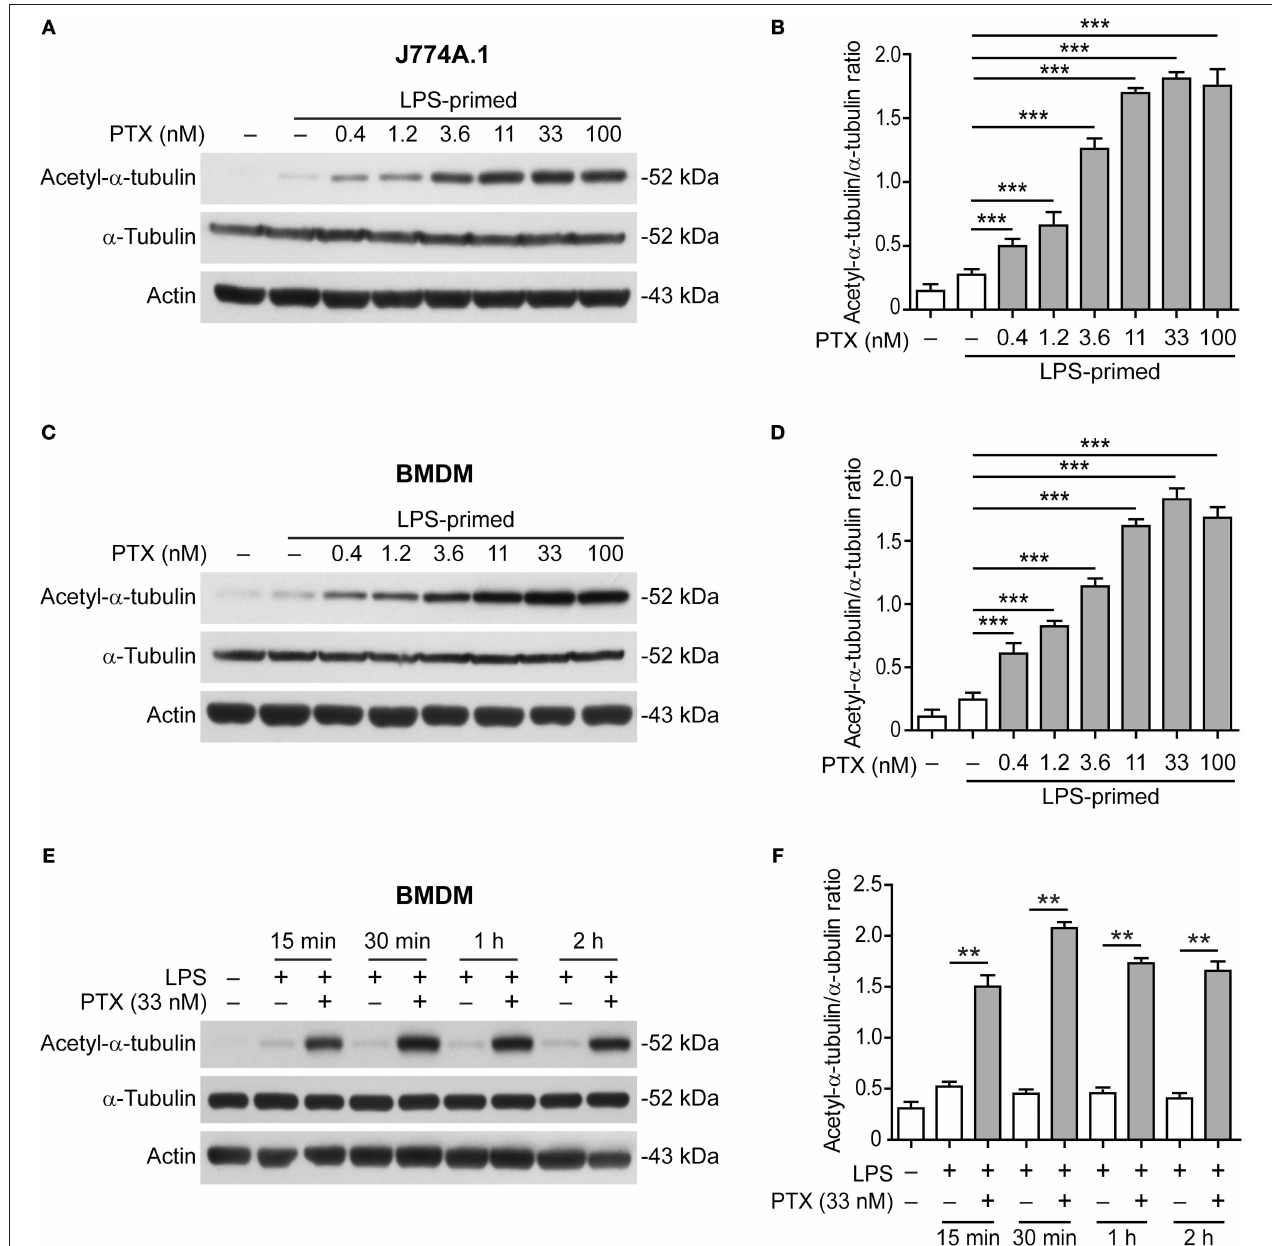
FIGURE 3 | Paclitaxel pretreatment increased the levels of acetylated α -tubulin. LPS-primed J774A.1 macrophages (A,B) and BMDMs (C–F) were pre-treated with graded concentrations of paclitaxel for 1h (A–D) or with paclitaxel (33nM) for indicated time periods (E,F) . Western blotting was used to assess the levels of indicated proteins in cell lysates (A,C,E) . Actin was used as the loading control. Histograms showing the quantification of acetylated α -tubulin relative to total α -tubulin are shown in (B,D,F) , respectively. Data were analyzed using the unpaired Student’s t -test (B,D) or non-parametric Mann–Whitney U -test (F) , which are shown as mean ± SD ( n = 3). ** P < 0.01; *** P < 0.001. PTX,